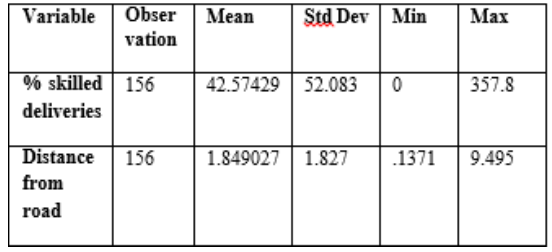
Table 1: Summary of proportion of skilled deliveries and facilities distances from the nearest roads.